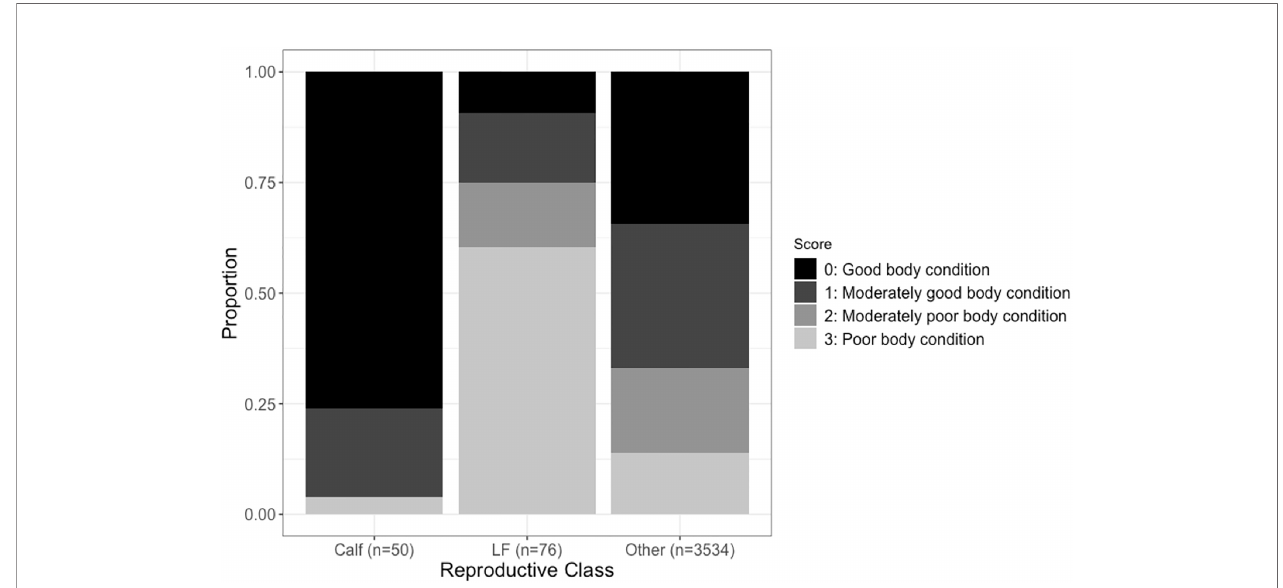
FIGURE 2 | The proportion of each body condition score by reproductive class as a stacked bar graph (LF, lactating